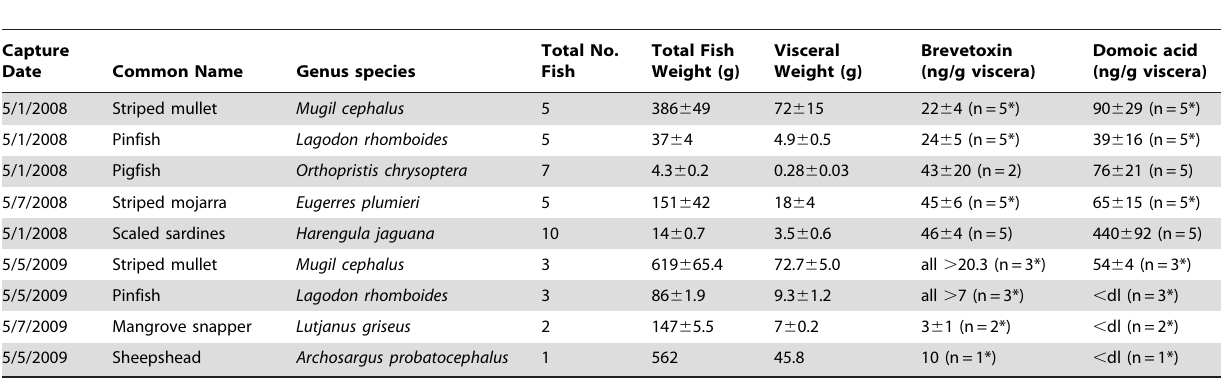
Table 2. Concentrations of brevetoxin and domoic acid found in viscera of various fish species in Sarasota Bay, Florida, USA during the May 2008 and May 2009 dolphin health assessments.